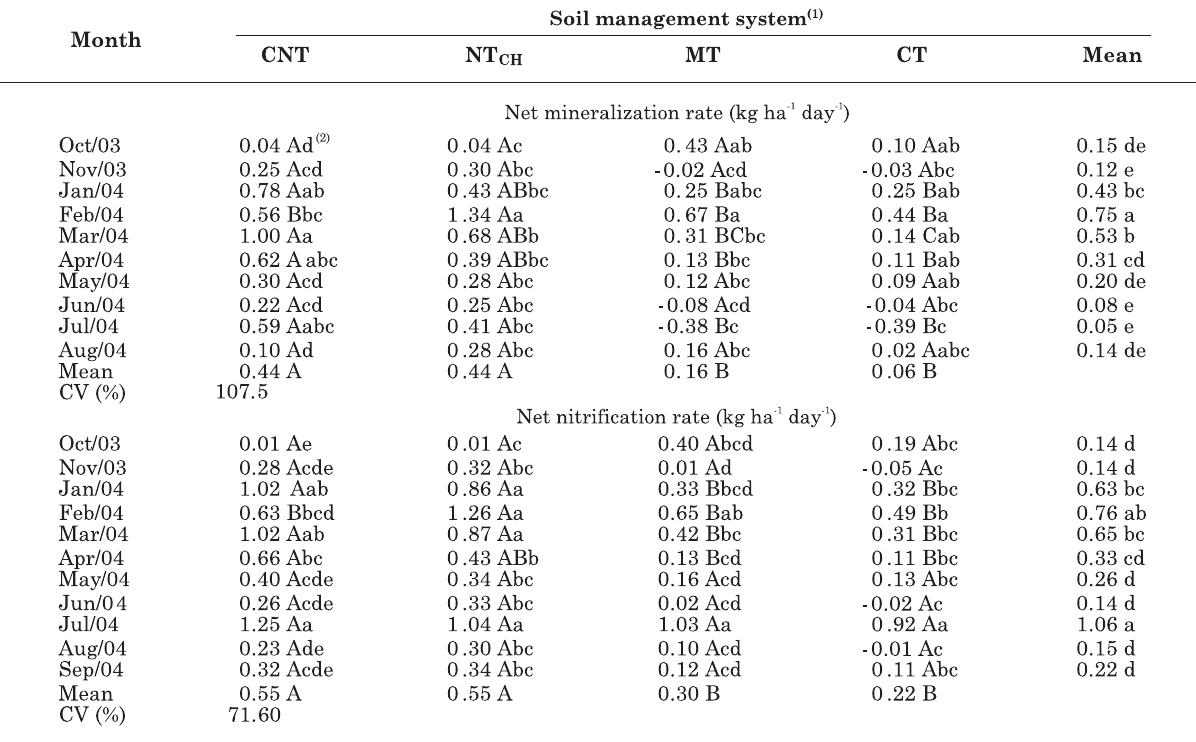
Table 4. Net N mineralization and nitrification rates in soil under different soil management systems in the layer 0–2.5 cm, from October 2003 to September